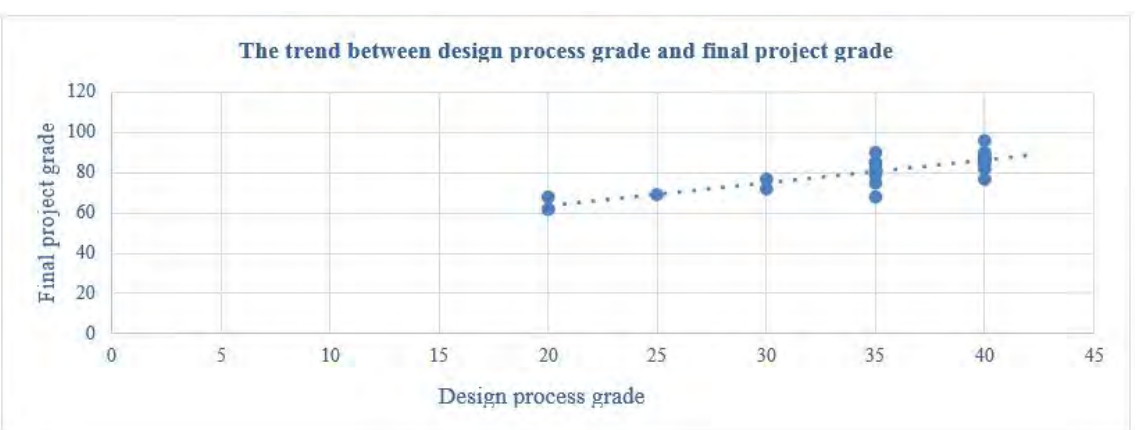
Figure 7. Positive trend result between design process grades and final studio grades